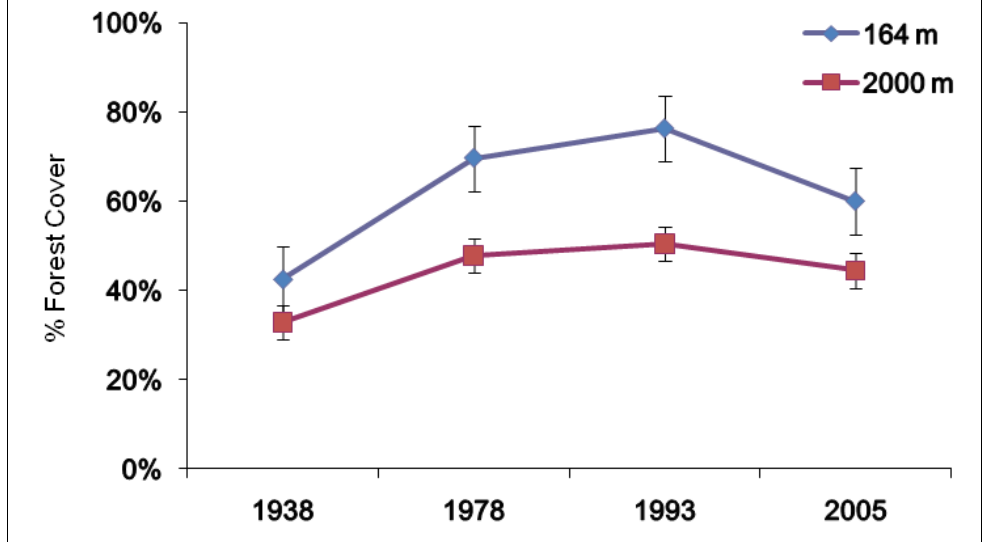
Figure 2. Average (±1 SE) percent forest cover within circular areas of 164-m and 2000-m radii for six wetlands in the greater Charlotte area of North Carolina, USA from